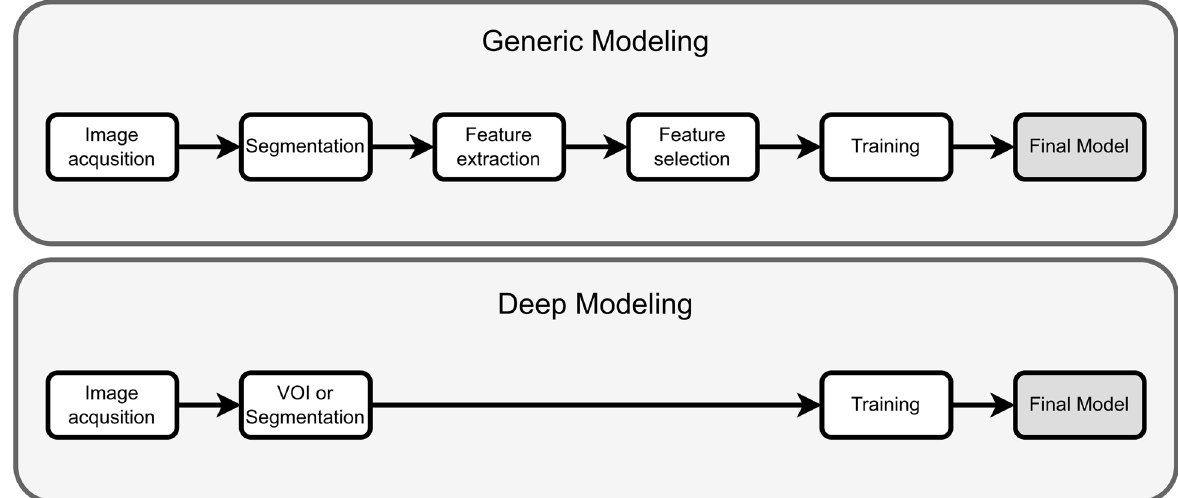
Fig. 1 Generic and deep modelling applied to